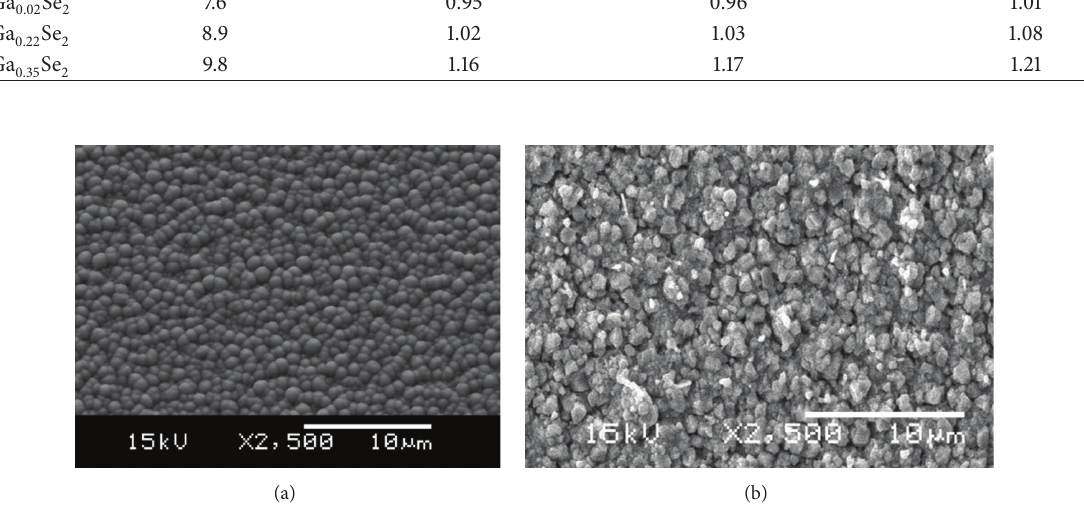
Figure 1: (a) The SEM pattern of the structural features of the precursor structure deposited at 200 ∘ C. (b) SEM micrographs showing the morphological features of a fully reacted Cu(In,Ga)Se 2 film. Selenization was conducted in elemental Se vapour at 550 ∘ C for 60 min.